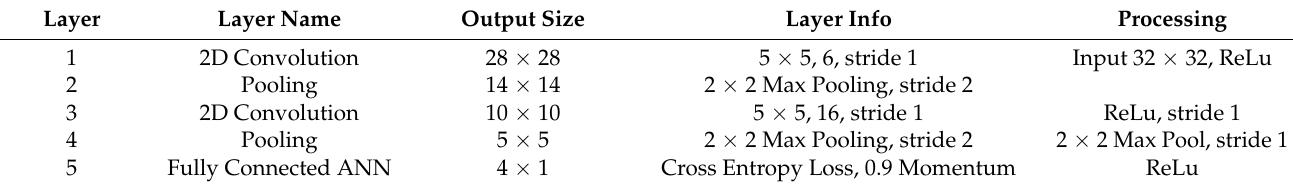
Table 1. The architecture of the convolutional neural network (CNN) used for classification of 400 sUAS images of cattle, horses, white-tailed deer, and Canada Geese, a subsample of the 1288 images collected that contained animals.